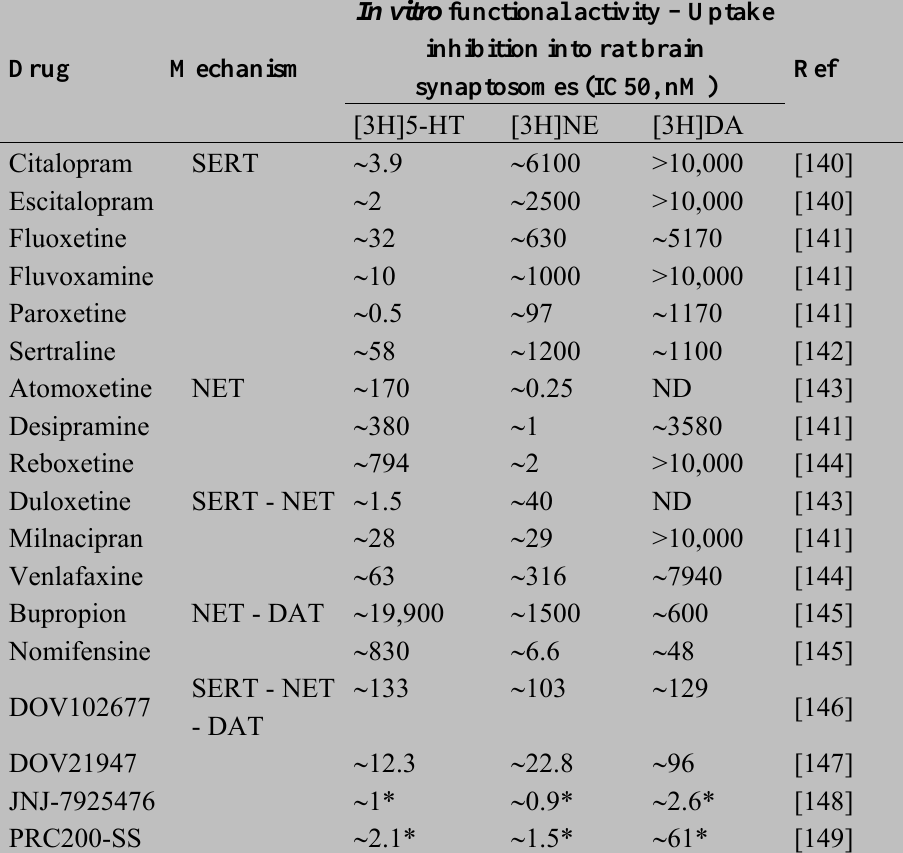
Table 1 . In vitro reuptake inhibition of monoamines transporters by monoaminergic reuptake inhibitors from rat synaptosomal fractions. * Ki values